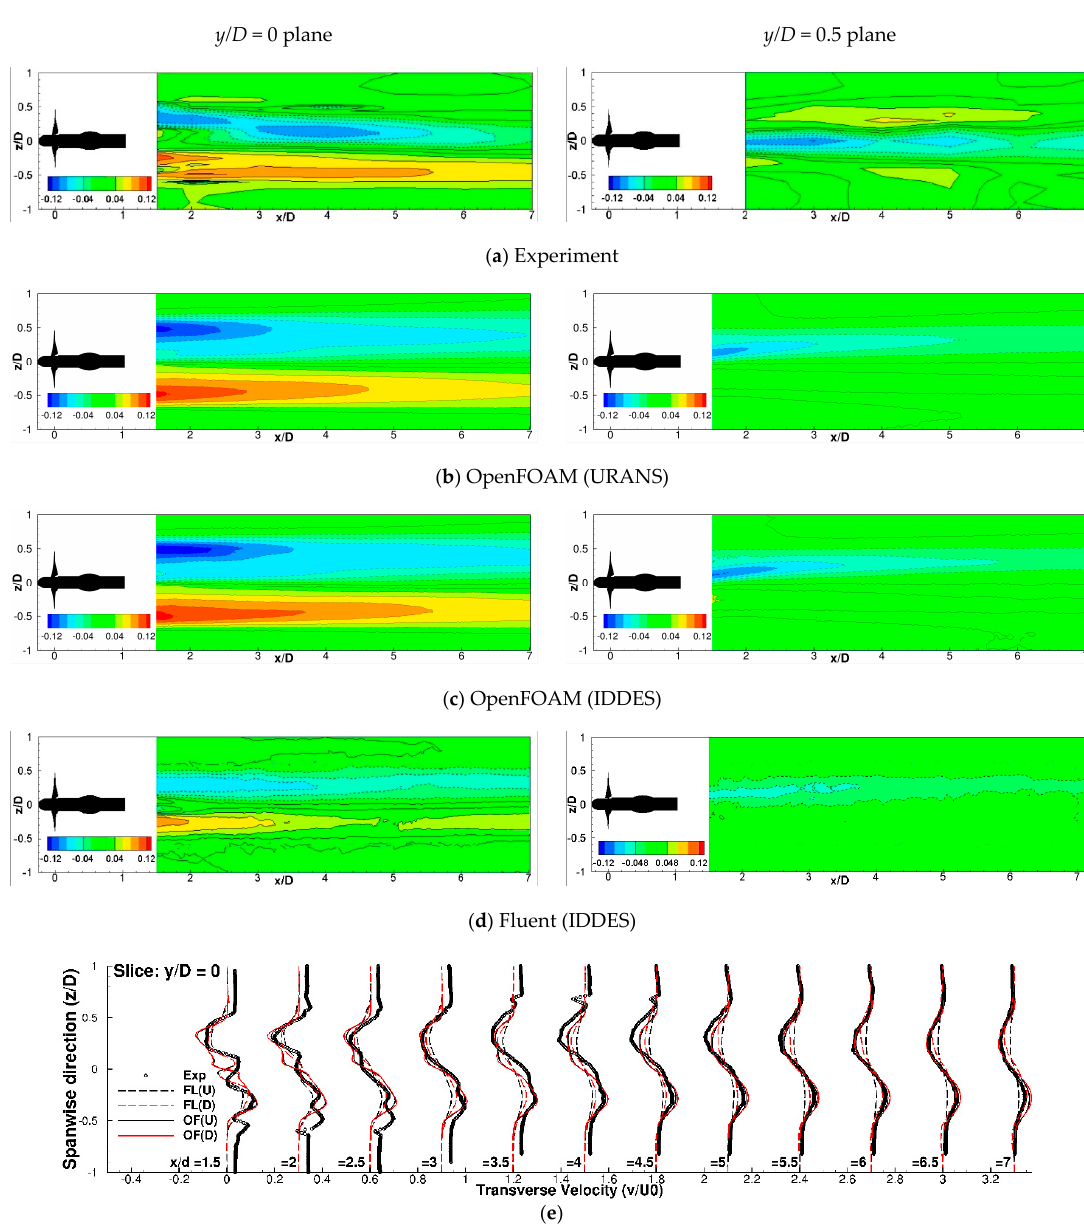
Figure 11. Mean transverse ( y ) velocity contour obtained from: ( a ) experiment, ( b ) OpenFOAM URANS, ( c ) OpenFOAM IDDES and ( d ) Ansys/Fluent IDDES. The left and right panels show the plots in y/D = 0 and 0.5 planes, respectively. ( e ) Transverse velocity profiles predicted in CFD simulations in y/D = 0 plane is compared with experimental data [2]. Experimental profiles for x/D ≥ 3 are shifted by z/D = 0.18, as the data shows asymmetry across z/D = 0. The experimental data for mean transverse velocities ( v ) at y/D = 0 plane in Figure 11 shows negative and positive values for positive and negative z/D , respectively. The peak | v |~ 0.12U 0 is observed at x/D ~1.5 and decreases downstream. The peak location shows asymmetry and the profile tends to shift towards the negative z/D direction. The transverse velocity on the stanchion side ( y/D = 0.5) shows a minimum around z/D ~ 0 with peak | v |~ 0.1U 0 whereas they do not show any well- defined structure on the non-stanchion side. CFD predictions show the negative and positive v contours consistent with the experiment. In the intermediate wake the tip vortices start to gradually lose their shape, the mixing between the free stream and core flow happens and the turbulence begins to decay much later. Analysis of the instantaneous solution shows that the antisymmetric velocity pattern is predicted due to the counterclockwise swirl imparted by clockwise rotating turbine in the wake. The peak | v | is obtained around z/D ~ 0.3, which is in between the blade tip and the root. The transverse velocity profile in the wake are compared in Figure 11e. Note that the experimental data was shifted by z/D = 0.18 for x/D ≥ 3 to adjust for the asymmetry. The OpenFOAM predictions show much better agreement with the experimental data compared to Ansys/Fluent, and no significant difference were observed between URANS and IDDES predictions. In Ansys/Fluent simulations, the IDDES predictions were somewhat better than those of URANS, and MILES predictions were similar to those of IDDES.